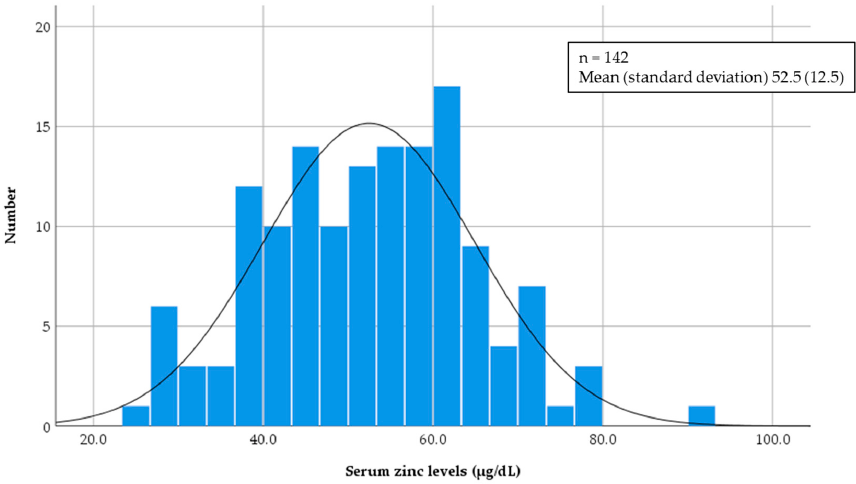
Figure 2. Histogram of serum zinc levels at baseline .